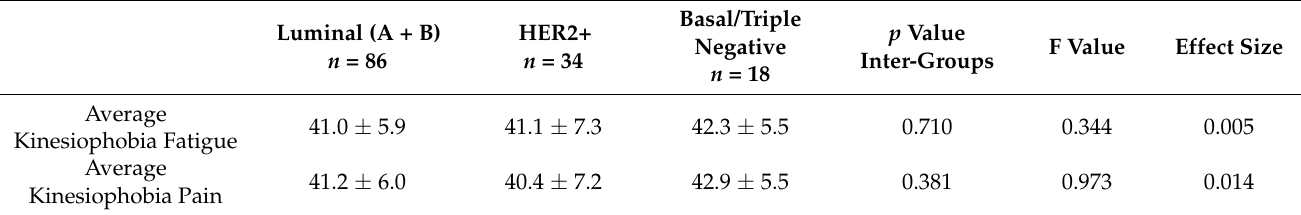
Table 6. The level of kinesiophobia and type of